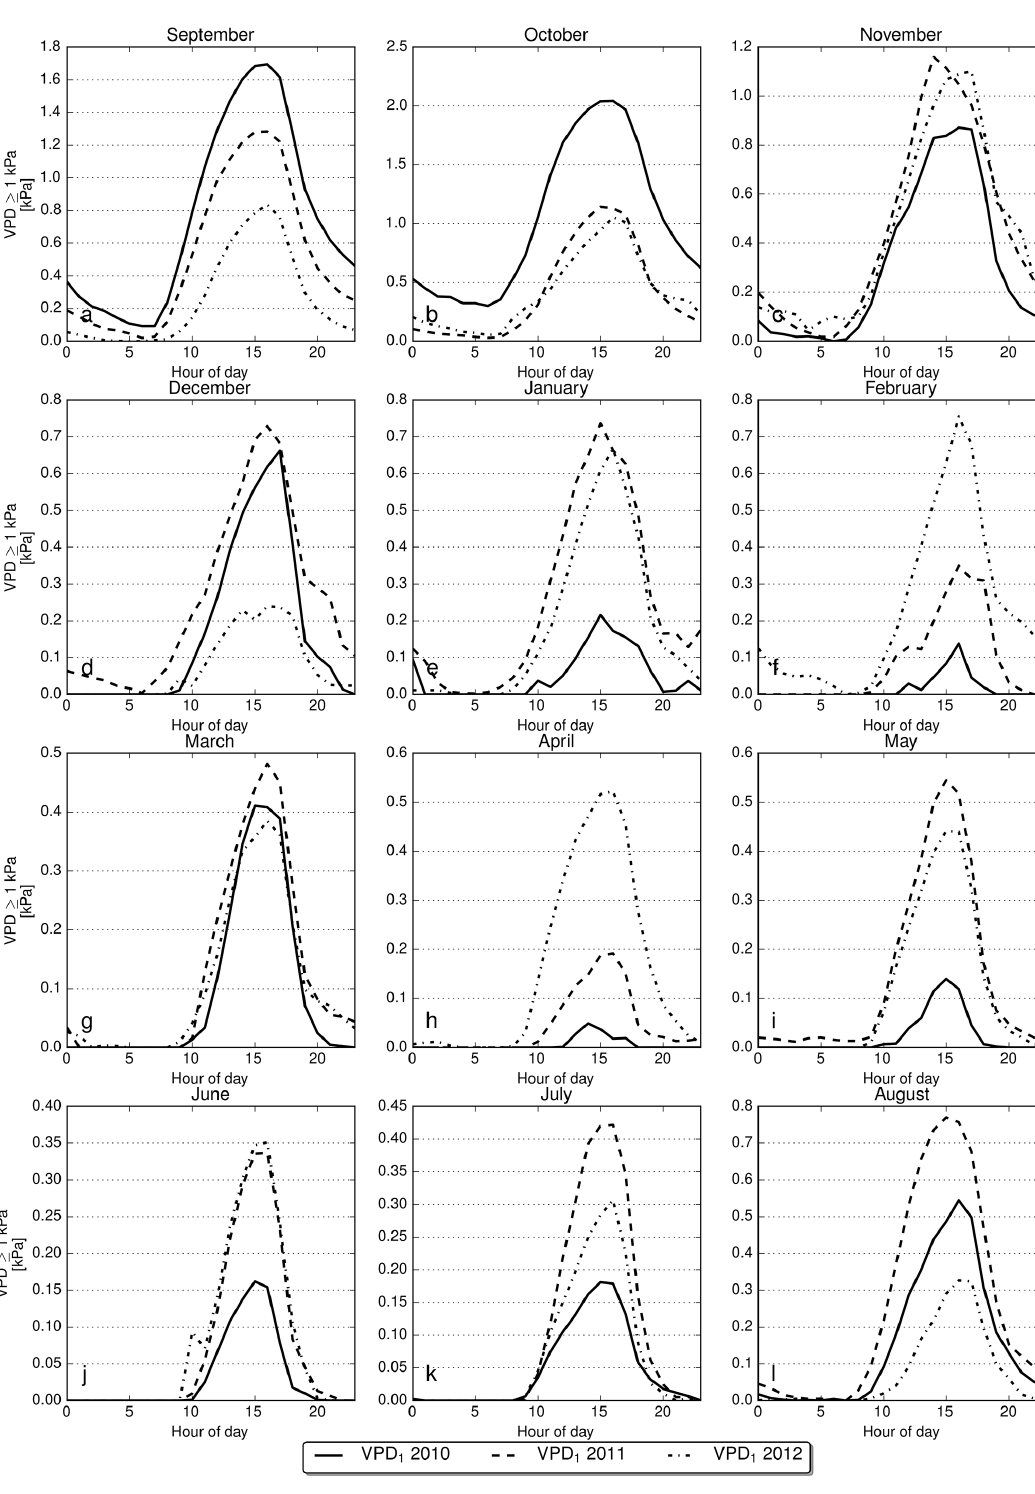
Figure 7. Monthly mean diurnal cycle of the VPD values above 1kPa, VPD 1 , for yearly periods between 1 September and 31 August in years 2010, 2011 and